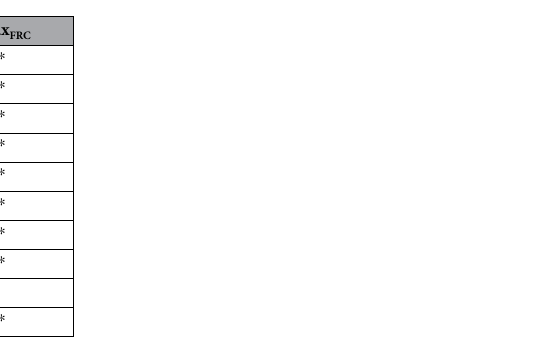
Table 3. Correlations between various parameters of infant lung function. * P < 0.05. ** P <